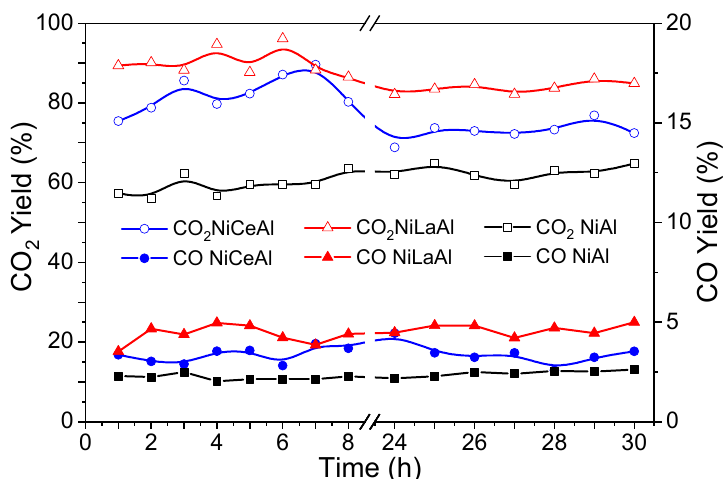
Figure 7. Carbon monoxide and carbon dioxide yields versus time on stream.